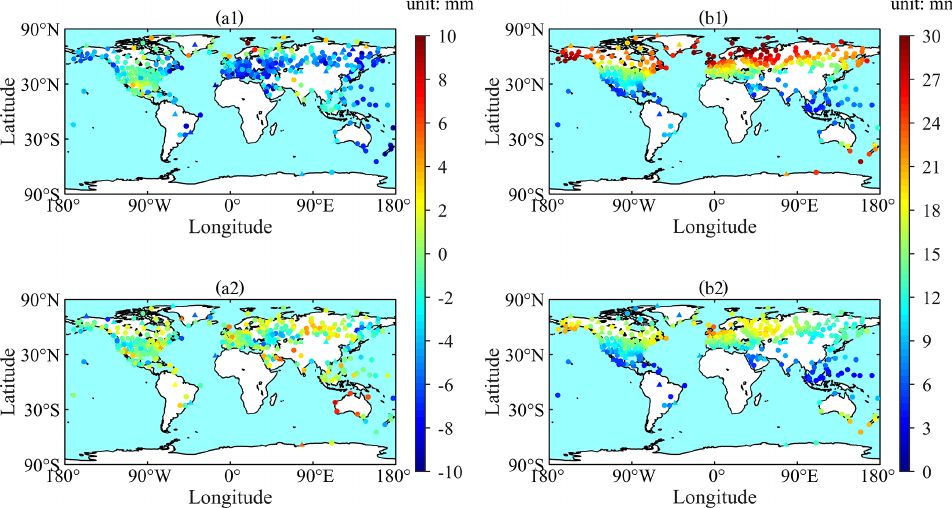
Figure 11. Bias (a1) and RMSE (b1) of ZHD-GPT3 and bias (a2) and RMSE (b2) of ZHD-GZHD at each of the 371 radiosonde stations during the 1-year period of 2020 (reference: ZHD-RS, the dots stand for the radiosonde stations that were used in the construction of GZHD, while the triangles stand for the radiosonde stations that were not used in the construction of